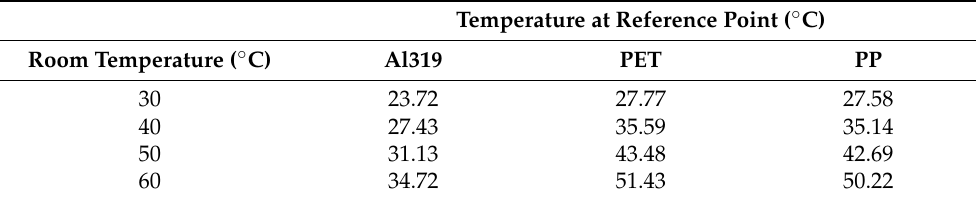
Table 3. Temperature results of the simulations ( ◦